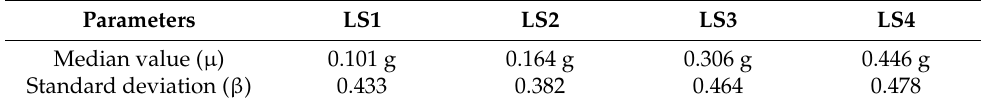
Figure 13. Structural results: relationships between PGA (g) and top-floor drifts (%).